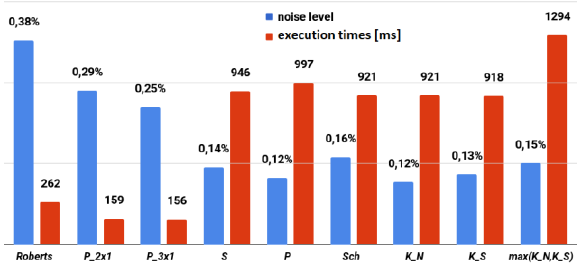
Fig. 2. Average noise in presented algorithms and times of execution in milliseconds on 10Mpx